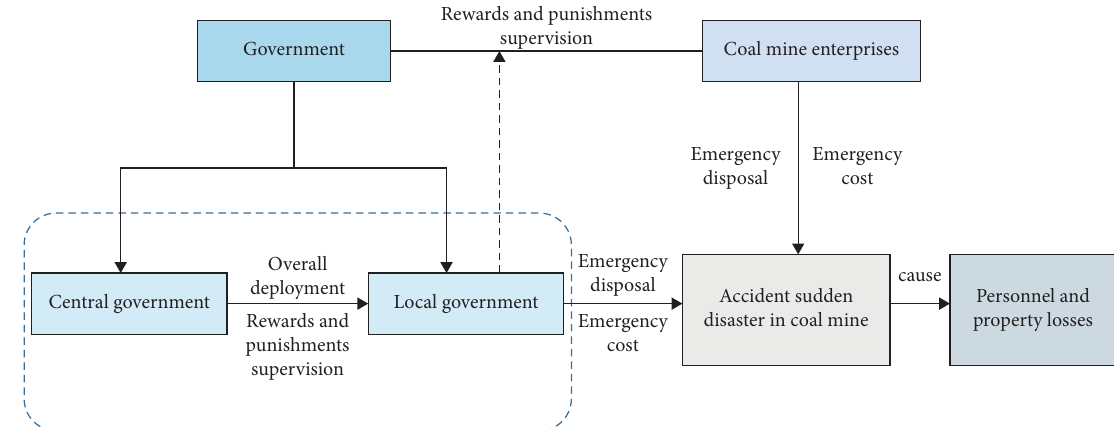
Figure 2: Game relationship among the central government, the local government, and coal mining